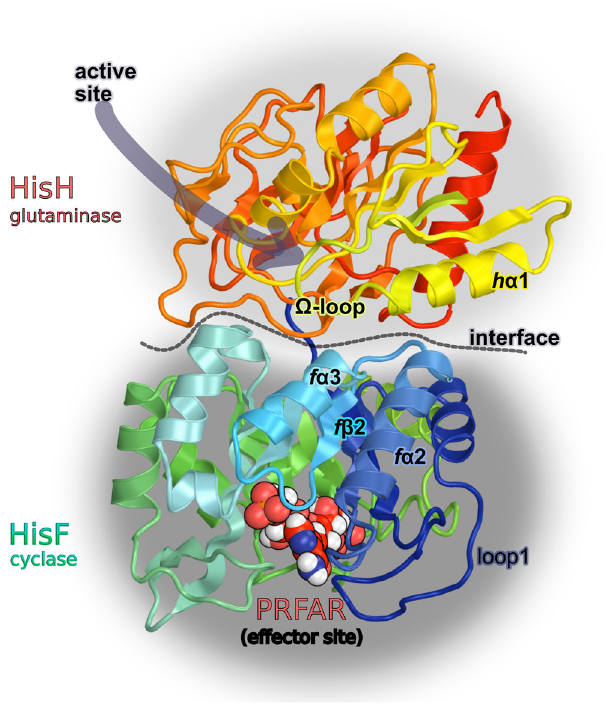
Fig. 1 | Molecular representation of IGPS. IGPS is a bienzyme composed of two subunits, i.e., HisF and HisH, that constitute the cyclase and glutaminase domains, here colored respectively in green-to-blue and red-to-yellow gradients, respec- tively, and separated by a dotted line which marks the interface between HisF and HisH. The labels ( f α 2, f α 3, f β 2, loop1, h α 1, Ω -loop) indicate secondary